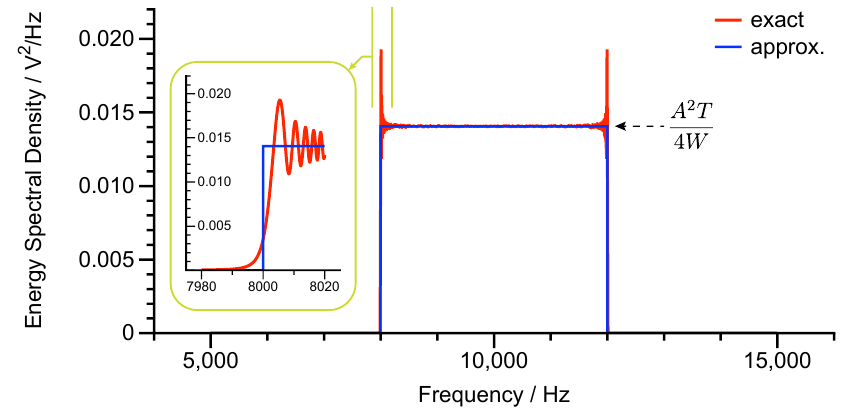
Figure 7. The energy spectral density of the chirp